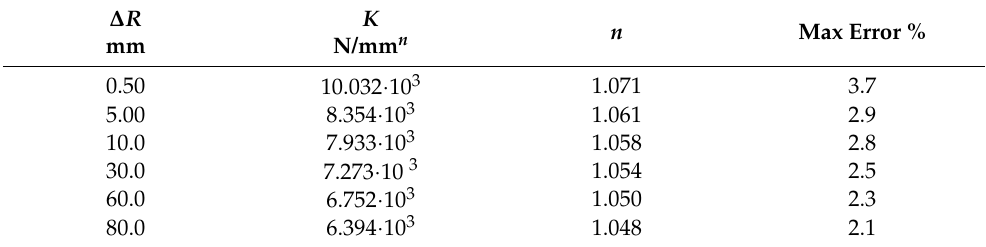
Table 7. Polynomial version of Goldsmith’s [23] contact force model (Aluminum).